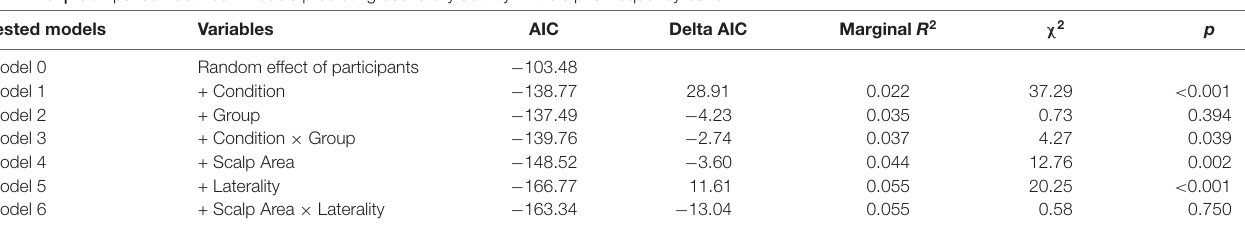
TABLE 6 | Comparison between models predicting oscillatory activity in the alpha frequency